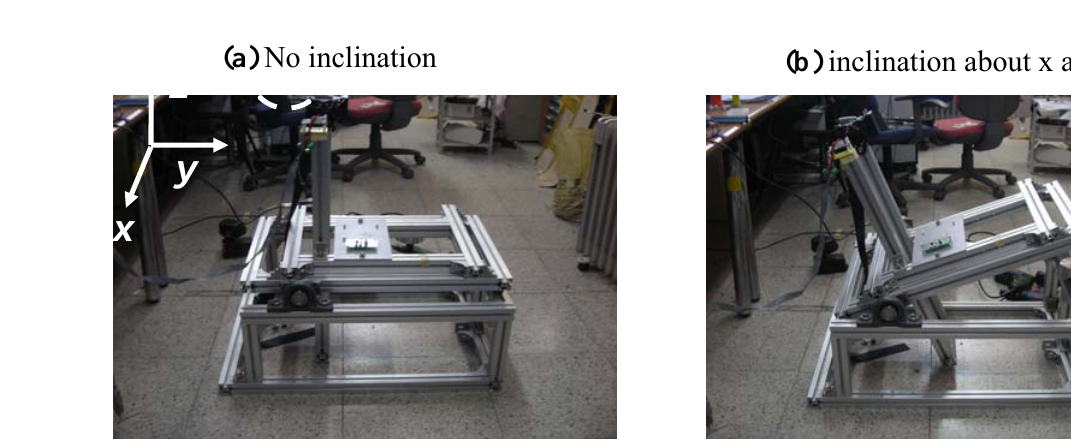
Figure 10. Equipment for incline